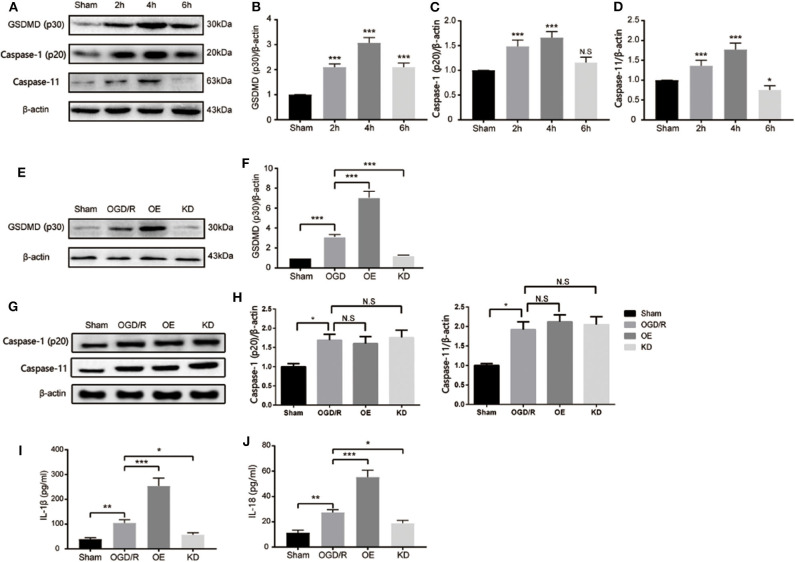
GSDMD is necessary for I/R induced pyroptosis and proinflammatory cytokine secretion in microglia BV2 cells. (A–D) Western blot analysis of the relative expression of cleaved-GSDMD (B), active caspase-1 (p20) (C), and caspase-11 (D) in microglia after OGD/R. (E,F) Relative expression of cleaved-GSDMD post shRNA-GSDMD interference or GSDMD overexpression in microglia. n = 5. (G,H) Relative expression of caspase-1 and caspase-11 in microglia post GSDMD silence or GSDMD overexpression. n = 5. (I,J) The expression of mature IL-1β and IL-18 in microglia BV2 cells were measured by ELISA at 4 h post OGD/R. n = 3. Data are presented as mean ± SD. *P < 0.05, **P < 0.01, ***P < 0.001 vs. the Sham group or relative group. GSDMD, gasdermin D; I/R, ischemia reperfusion; OGD, oxygen glucose deprivation.